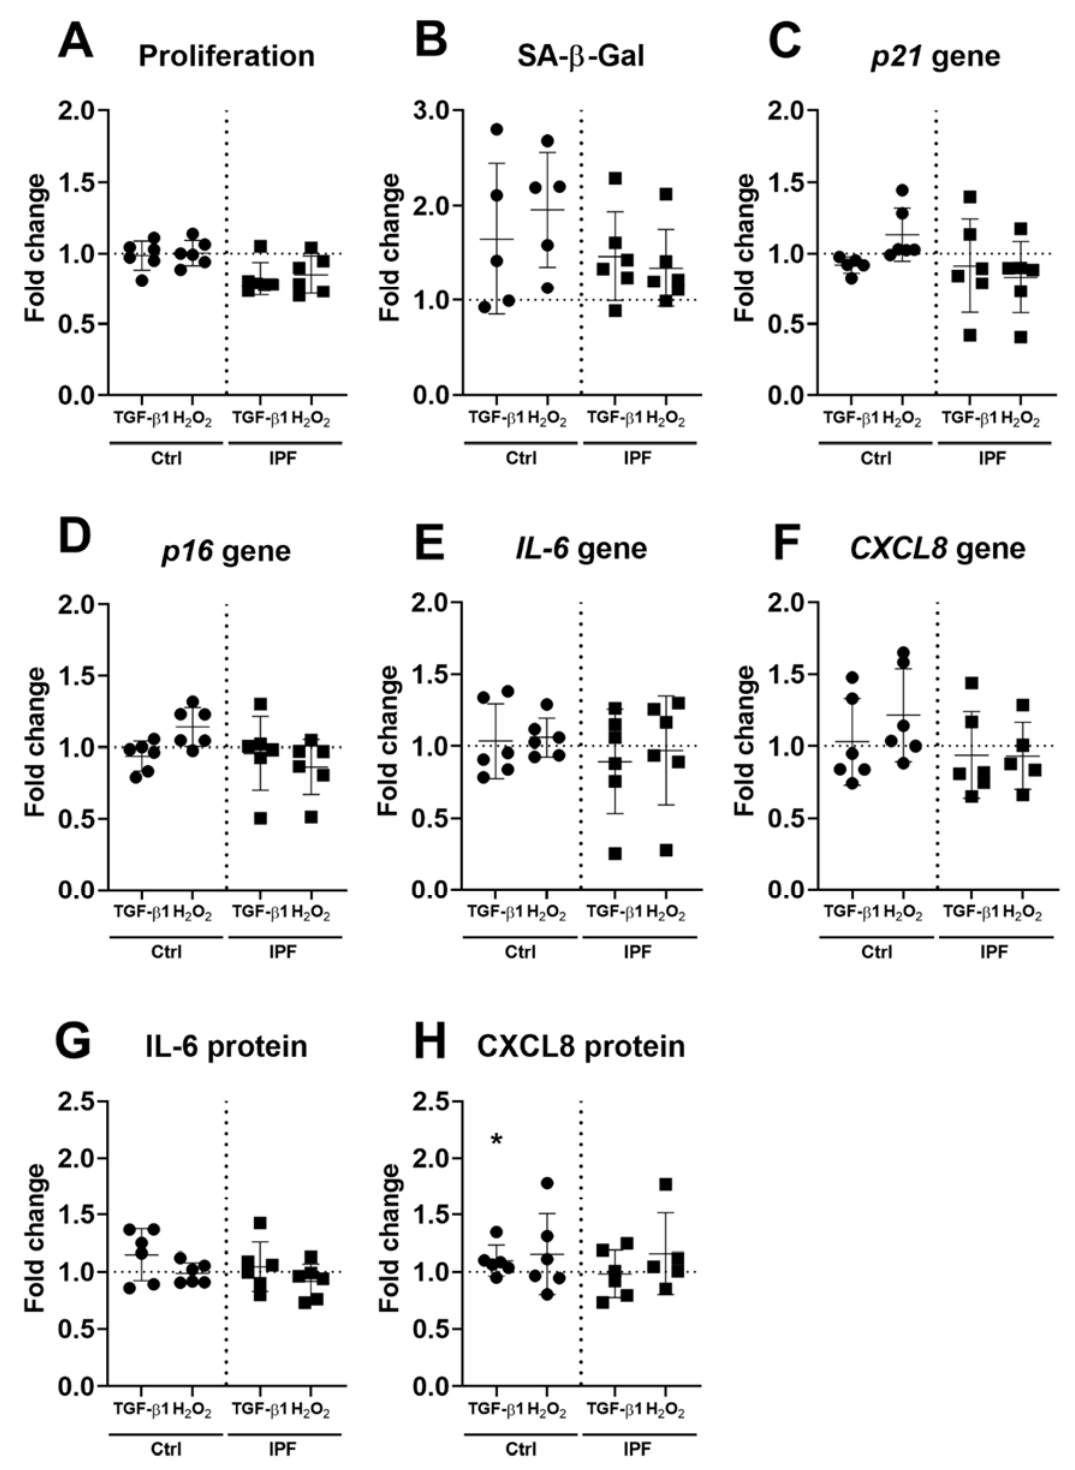
Figure 4. Markers of senescence in fibroblasts cultured on ECM derived from fibroblasts treated with either H 2 O 2 or TGF- β 1. Fibroblasts were cultured for three days on Ctrl- or IPF-derived ECM. Proliferation was assessed by cell enumeration ( A ), and SA- β -Gal-positive cells were counted after cytochemical staining ( B ). Relative levels of the cell-cycle inhibitors p21 Waf1/Cip1 and p16 Ink4 a ( C , D ). Panels ( E – H ) show gene expression and protein secretion of IL-6 and CXCL8 after three days of culture. Both gene expression and levels of cytokine production were normalised as described before and expressed as fold change to their respecting Ctrl– or IPF–ECM without treatment ( n = 4–6). Data were analysed using repeated measures one-way ANOVA, or, if data points were missing, a mixed-effects analysis (REML), and considered significant at * p <